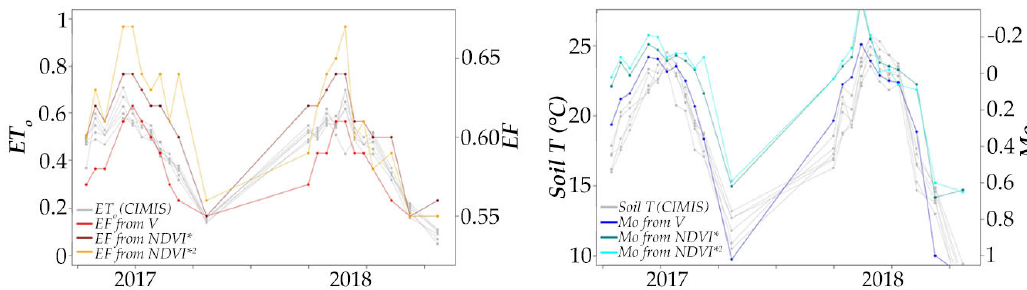
Figure 10. Comparison to ground observations. EF (L) and Mo estimates (R) from maximally-vegetated pixels from all cloud-free observations from 2017 and 2018 are compared against CIMIS data. Strong seasonality is evident in al observations. EF from SMA-derived V fraction tracks CIMIS-estimated ET o more accurately than EF from NDVI *. EF from NDVI * 2 shows pronounced oscillations which are not present in the CIMIS data. Mo from SMA-derived V fraction tracks soil T much more accurately than Mo from NDVI * or NDVI * 2 . Mo estimated using the spectral indices does not capture the curvature of the seasonal peak, likely as a result of effects of soil background reflectance in pixels with sparse (early season) and senescent (late season)